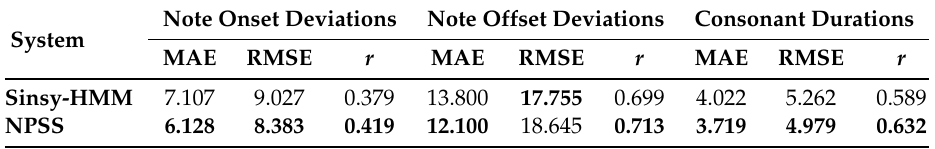
Table 2. Quantitative results for the timing models trained on natural singing. The table lists Mean Absolute Error (MAE) and Root Mean Squared Error (RMSE), both in 5ms frames, and Pearson correlation coefficient r . Note that the Sinsy-DNN system uses the same HMM-based duration model as the Sinsy-HMM system, so it is excluded from the comparison. The IS16 system used durations predicted by the NPSS system. The HTS system is only considered when comparing systems trained on pseudo singing, but should be roughly equivalent to